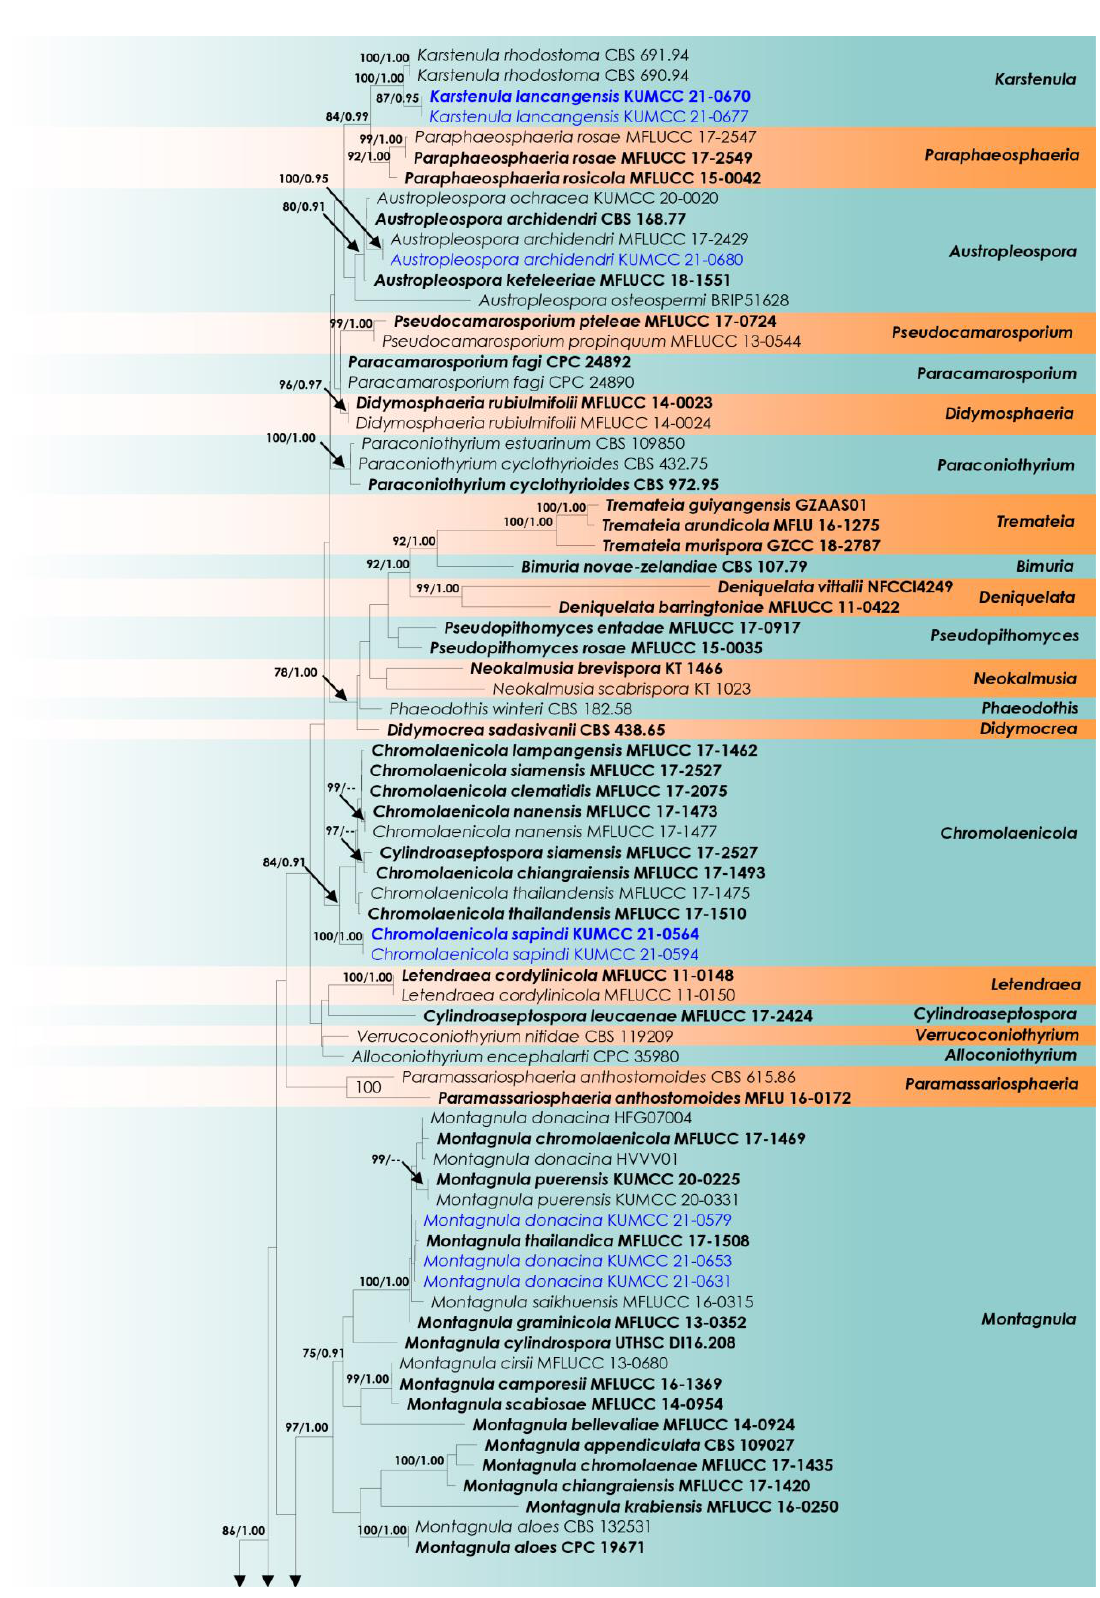
Figure 1. Phylogram generated from ML analysis based on the combined SSU, LSU, ITS, and tef 1- α Figure 1. Cont dataset. Bootstrap support values for ML equal to or higher than 75%, and BYPP equal to or greater than 0.90 are shown above the nodes. The ex-type strains are in bold, and new isolates are in blue. The tree is rooted with Periconia didymospora (MFLU 15-0057 and MFLU 15-0058).